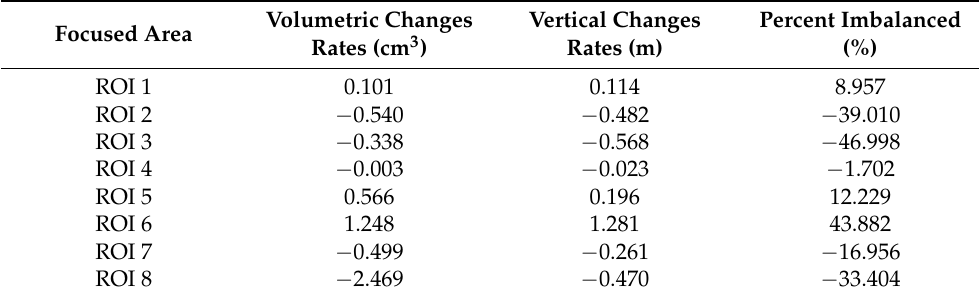
Table 2. Geomorphological change detection rates which showing the volumetric, vertical, and percent imbalances at all